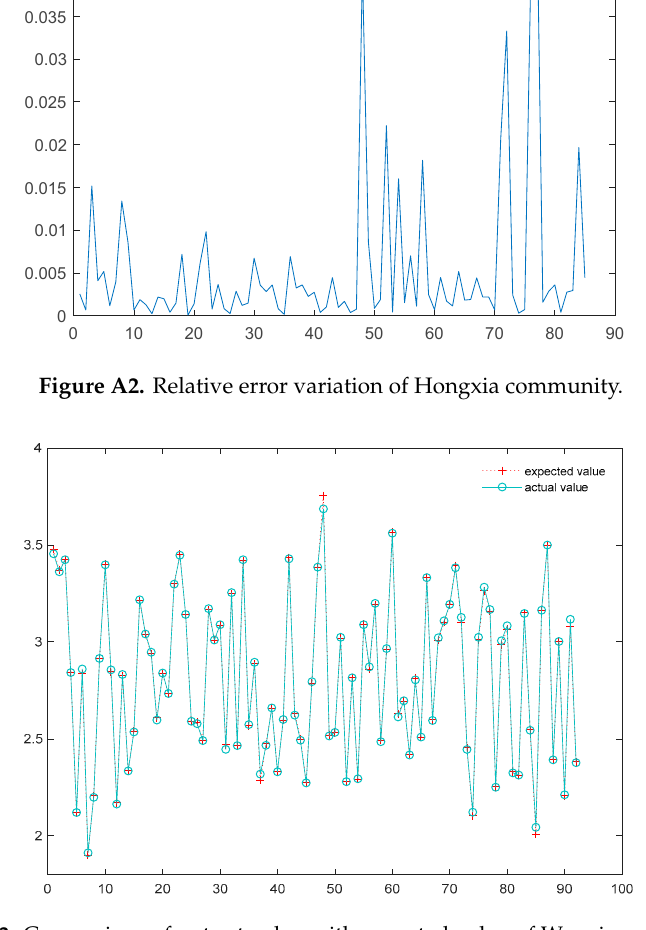
Figure A3. Comparison of output value with expected value of Wannian community.